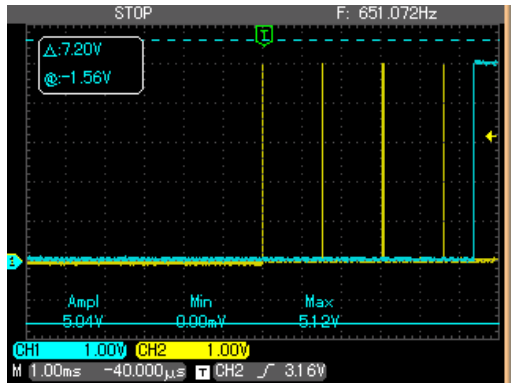
Figure 16. Oscilloscope screenshot to show the delay between the PFM signal (yellow) and the PWM one (blue).